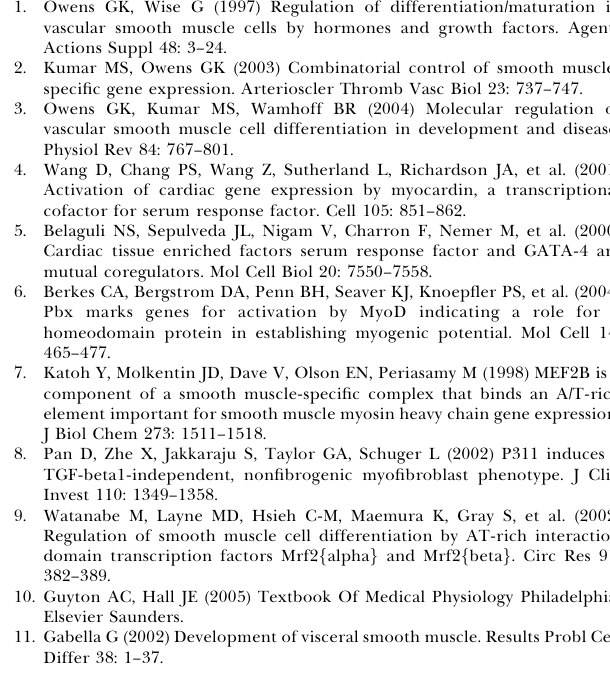
Figure S1. Gene Expression Program of Serum Responses of Fibroblasts and Smooth Muscle Cells (A, B) Hierarchical clustering of a total of 1,866 elements that display a greater than 3-fold change in mRNA expression in more than one sample when fibroblasts and SMCs are exposed to serum. The triangles represent the time course of the indicated cell types. Identified clusters of genes with unique expression patterns are marked by vertical bars and expanded in (B) with the names of representative genes shown on the right.